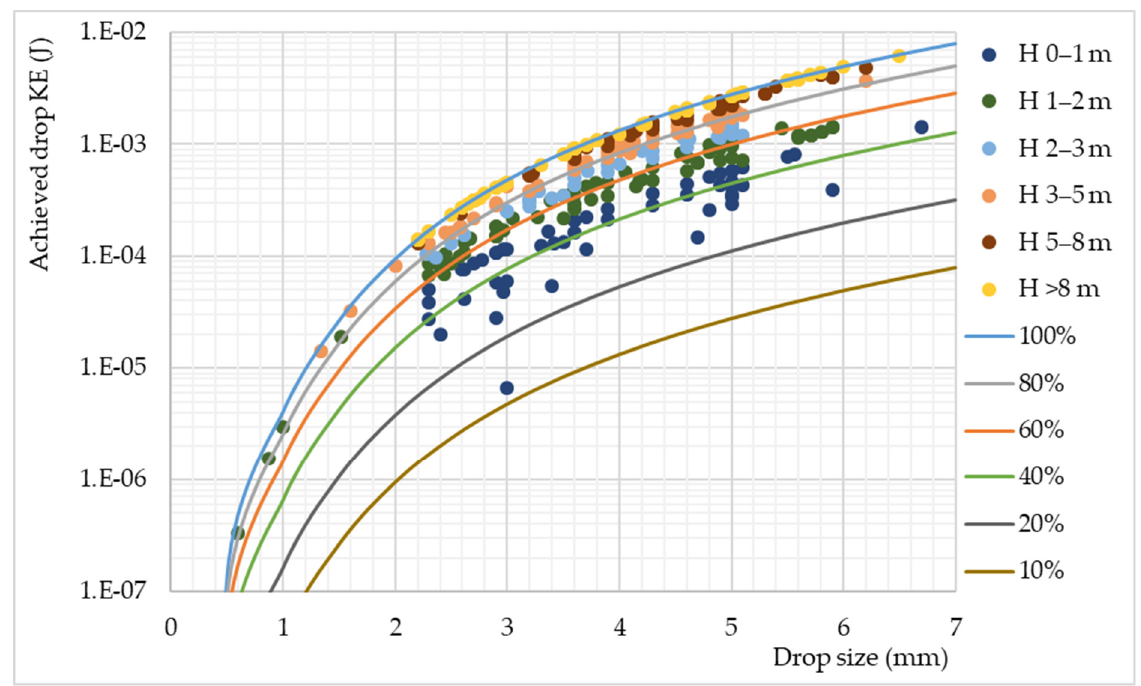
Figure 12. Achieved drop KE of simulated precipitations for different heights based on the mathe- matical model of [57]. Note: the analysis did not include simulations for which drop height values were given in a range.